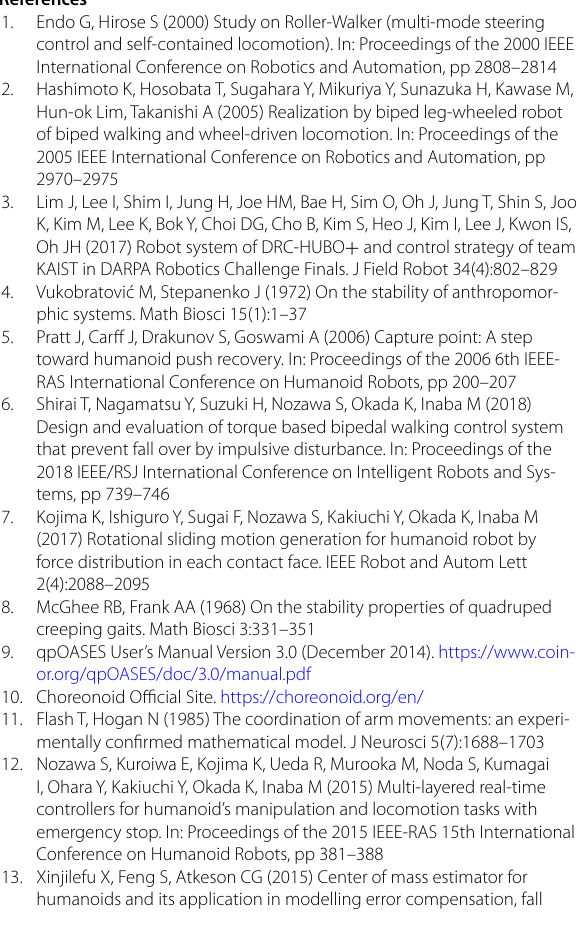
fall prevention for leg-wheel transition in Fig. 19 under the different floor conditions (on the rough carpet floor and on the slippery tile floor). The difference in these floor conditions is flat floor surface and further con- sideration is needed in order to validate the proposed locomotion approach on sloping terrain and confirm the limits of robustness of this leg-wheel robot.